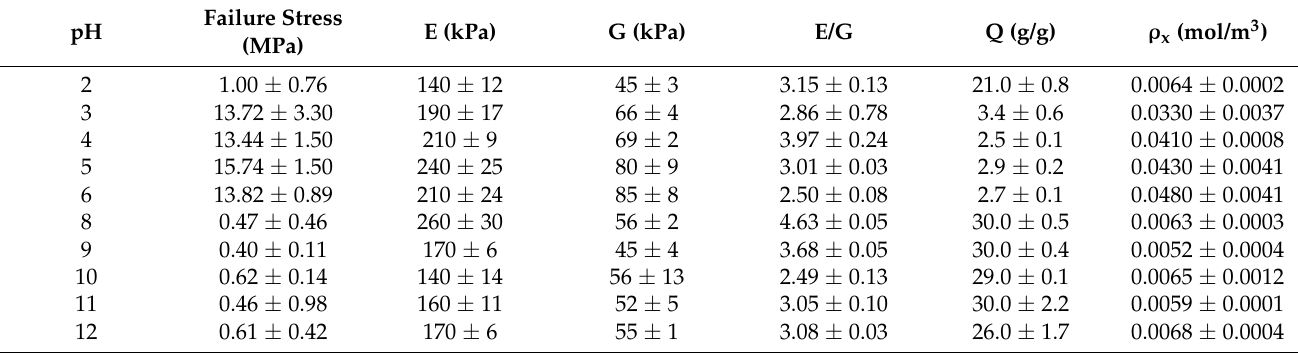
Table 1. Mechanical Properties of PAAc/PVAm IPNs.